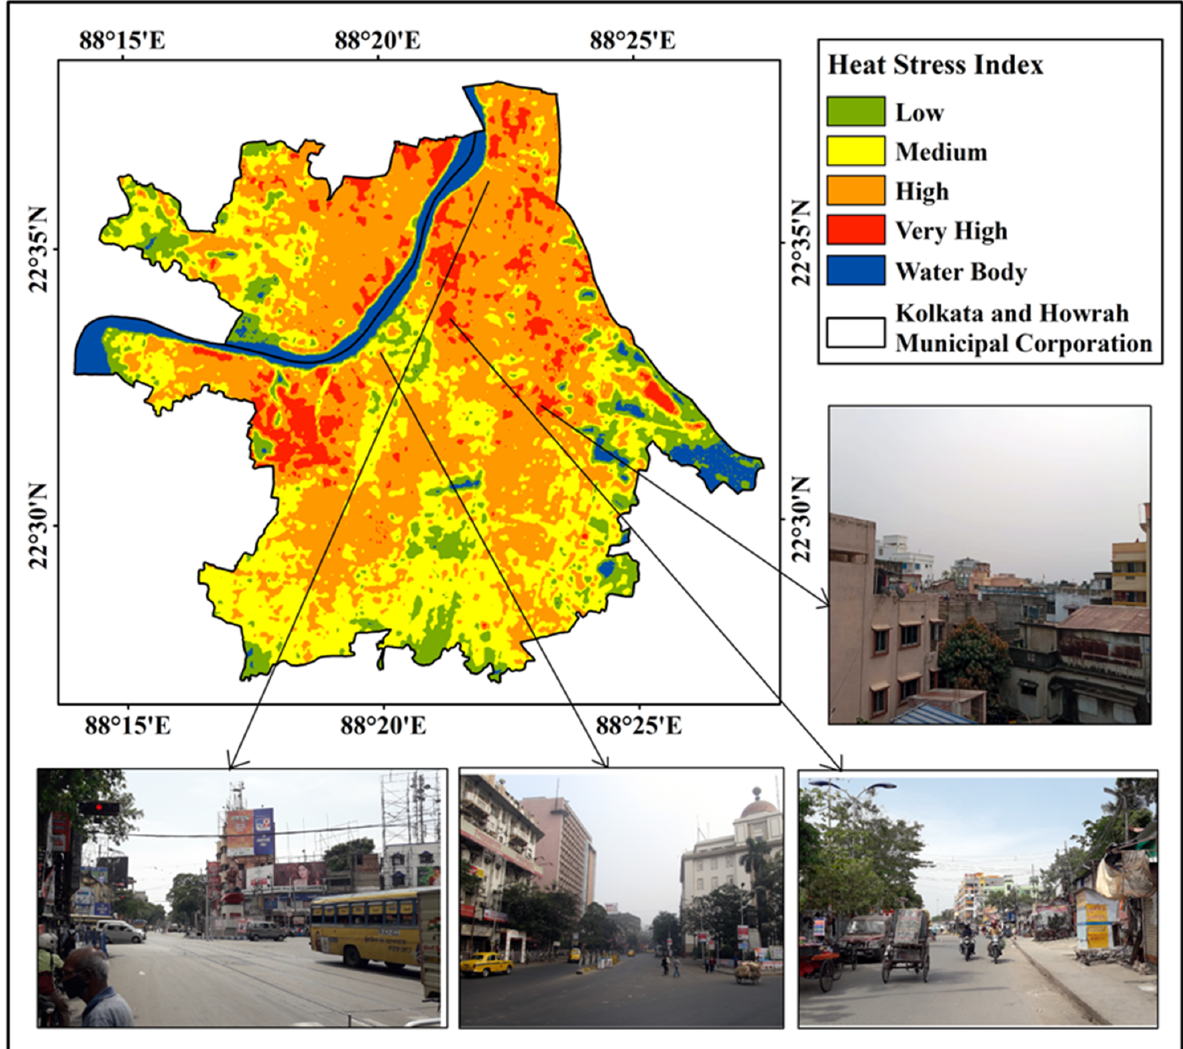
Figure 15. Heat stress index map of West Bengal (Kolkata and Howrah).